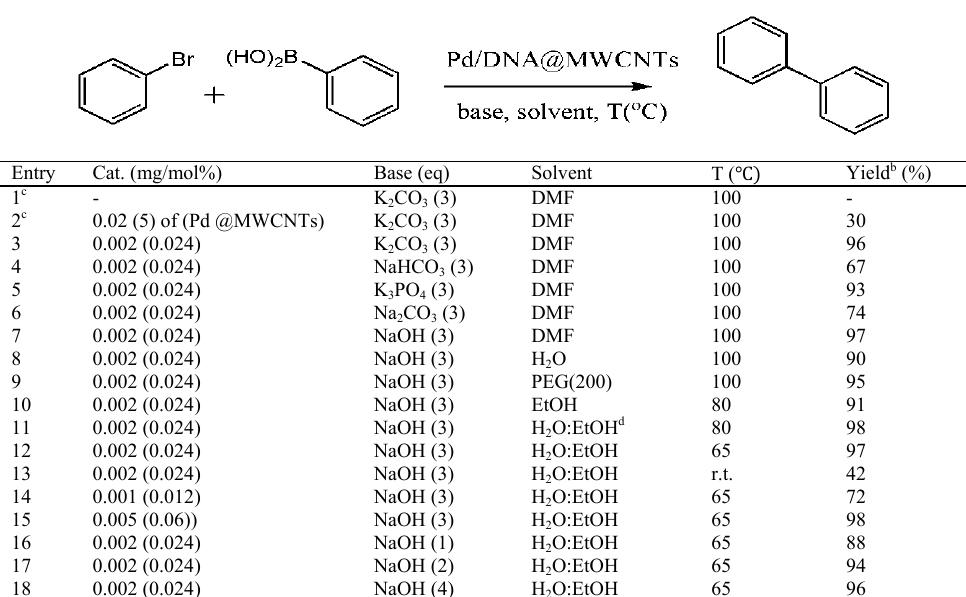
Table 1 . Optimization of Suzuki Reaction Conditions a